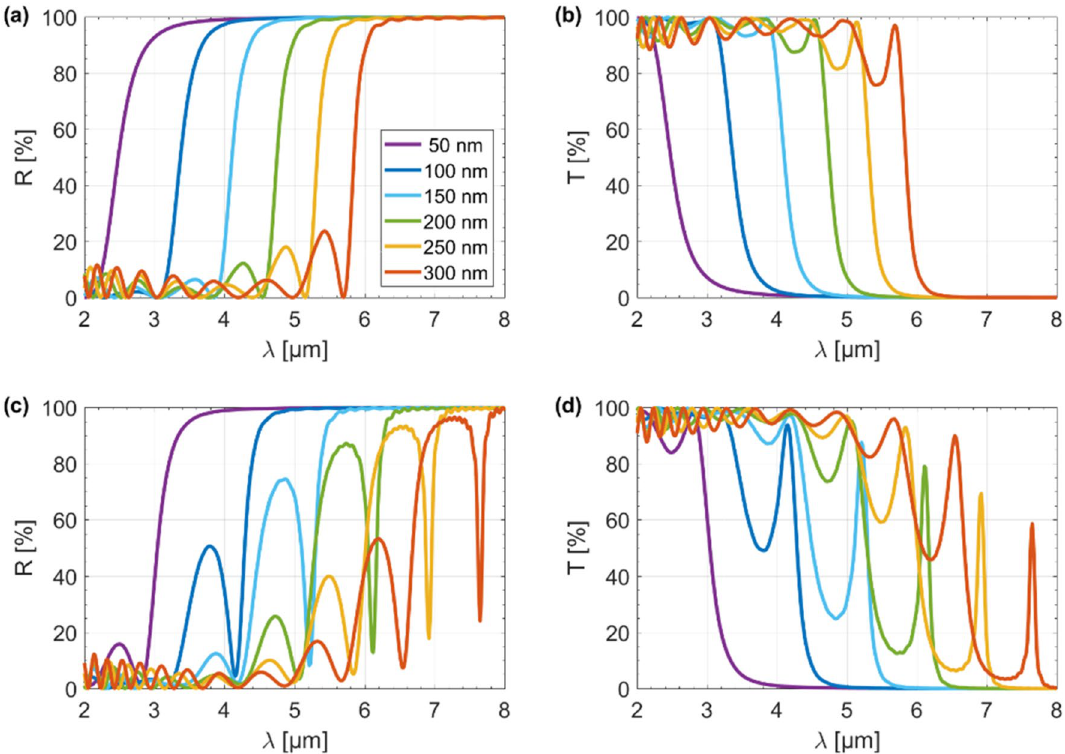
Figure 5. Reflection ( a ) and transmission ( b ) spectra for the unmodulated structure and reflection ( c ) and transmission ( d ) spectra for the modulated structure as a function of the base dielectric thickness ( t 0 adopting triangle wave function) increased, we observe a redshift of the resonance peak. In addition, as the base thickness of the dielectric increases from 50 to 300 nm, the intensity of the resonance also increased. At the same time, the transmission of the device started to decrease because of increasing reflection and absorption. Thus, a base dielectric thickness of t 0 = 200 nm, which still had a transmission of ~ 80%, was chosen to optimize the performance of the tunable microcavity in mid-IR. The above-mentioned properties of the hyperbolic microcavity, i.e., enhancement of the electric field intensity, shift of the FP resonance spectral position, and microcavity Q-factor can be expressed as a function of both, the base dielectric thickness ( t 0 ) that we modulate, and the applied gate voltage (V g ), as depicted in Fig. 6a–f. In Fig. 6a,b, we can notice that the closer to the center of the stack, the intensity of the electric field increases which is consistent with the principle of operation of a hyperbolic microcavity described above, i.e., interaction between cavity plasmon modes is the strongest in the middle of the stack, where the dielectric thickness is the largest. Next, we found that with an increase in the base thickness of the dielectric from t 0 = 50 to 300 nm, there was a more than six-fold increase in the enhancement coefficient for the structure with modulation of the dielectric thickness, compared with the unmodulated one that had only a two-fold increase, as evident from Fig. 6c. Furthermore, in case of the unmodulated stack, by varying the dielectric thickness between t d = 50 and 300 nm; a blue/red-shift of the transition from a high transmission to high reflection up to 2.8 µm was observed; this corresponds with a shift of the topological transition from elliptic to a type II hyperbolic dispersion also by 2.8 µm. Importantly, tunability of a FP resonance peak was also considered. In this case, the largest shift of 3.8 µm occurred for a change of the base dielectric thickness from t 0 = 50 to 300 nm. Moreover, the increase of the gate voltage from V g = 2 to 8 V resulted in more than a two-fold increase in the enhancement coefficient for modulated GHMM compared to only almost one and a half-fold increase for unmodulated GHMM, as shown in Fig. 6d. In order to fully characterize the hyperbolic microcavity, the quality factor (Q-factor) of the FP resonances was calculated in terms of both the change in base dielectric thickness and the applied voltage, as illustrated in Fig. 6e,f. Our results show that Q-factor is proportional to both the increase in the base dielectric thickness and the applied electrical excitation. It should be noted, that for practical applications critical is the implementation of a cavity with both high Q-factor and small modal volume (Vol). The ratio Q/Vol regulates the strength of the multiple cavity interactions, and an ultra-small cavity enables a large-scale integration and a single-mode operation for a broad range of wavelengths 51,52 . Therefore, the presented concept based on GHMMs seems to be particularly promising. Additionally, unlike classic resonant microcavities, the Q-factor increases with increasing electrical stimuli, and thus the efficiency of the device also increases. It is crucial in state-of-the-art technologies, as it gives the possibility of increasing the Q-factor and tunability at the same time. In the last step, we studied the angular reflection characteristics, as well as the spectral position of the dip (corresponding to the FP peak in transmission) for both the TE and TM modes for the hyperbolic microcavity, as shown in Fig. 7a–c. It should be noted that the value of the chemical potential was constant at V g = 5 V, and the